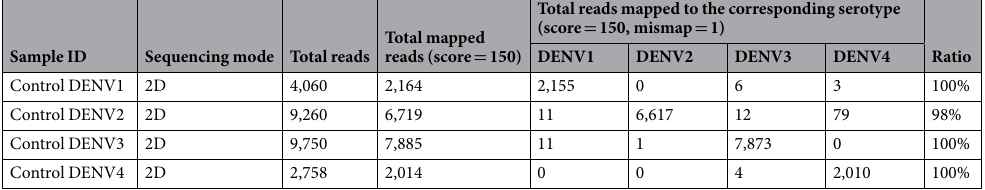
Table 1. Sequence statistics. Sequence data statistics from the control templates of in vitro cultured viruses showing the number and percentage of sequence reads that correspond to the genome sequences of the indicated serotype for each control